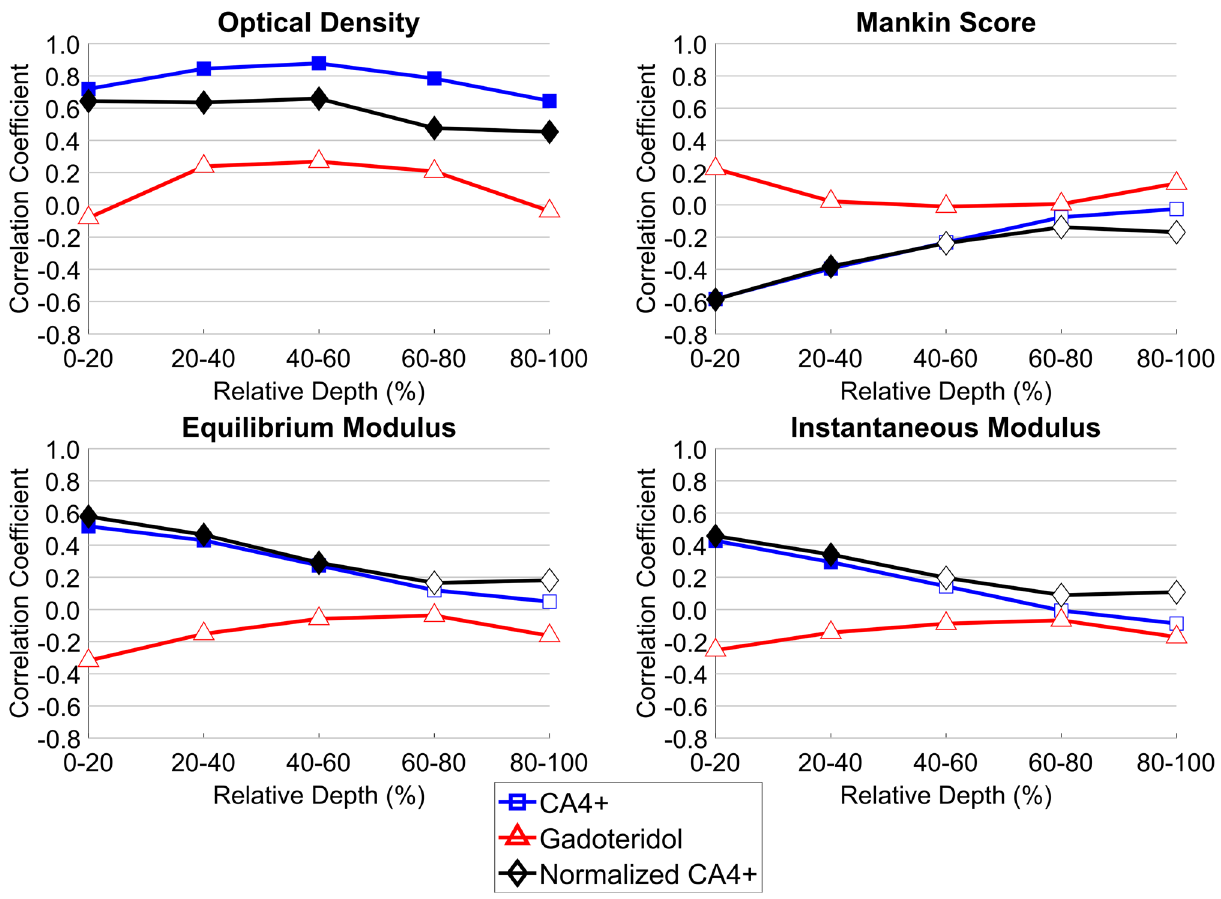
Figure 6. Depthwise Spearman’s correlation coefficients ( ρ ) between the reference parameters, and the CA4+ partition, normalized CA4+ partition and gadoteridol partition. Gadoteridol partition is provided for illustration purposes since it is used for the normalized CA4+. Filled marker indicates statistically significant correlation ( p < 0.05). The cartilage surface is at 0% and the cartilage-bone interface at 100%.